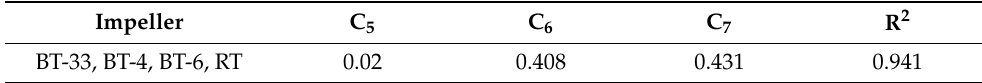
Table 3. Constants in Equation